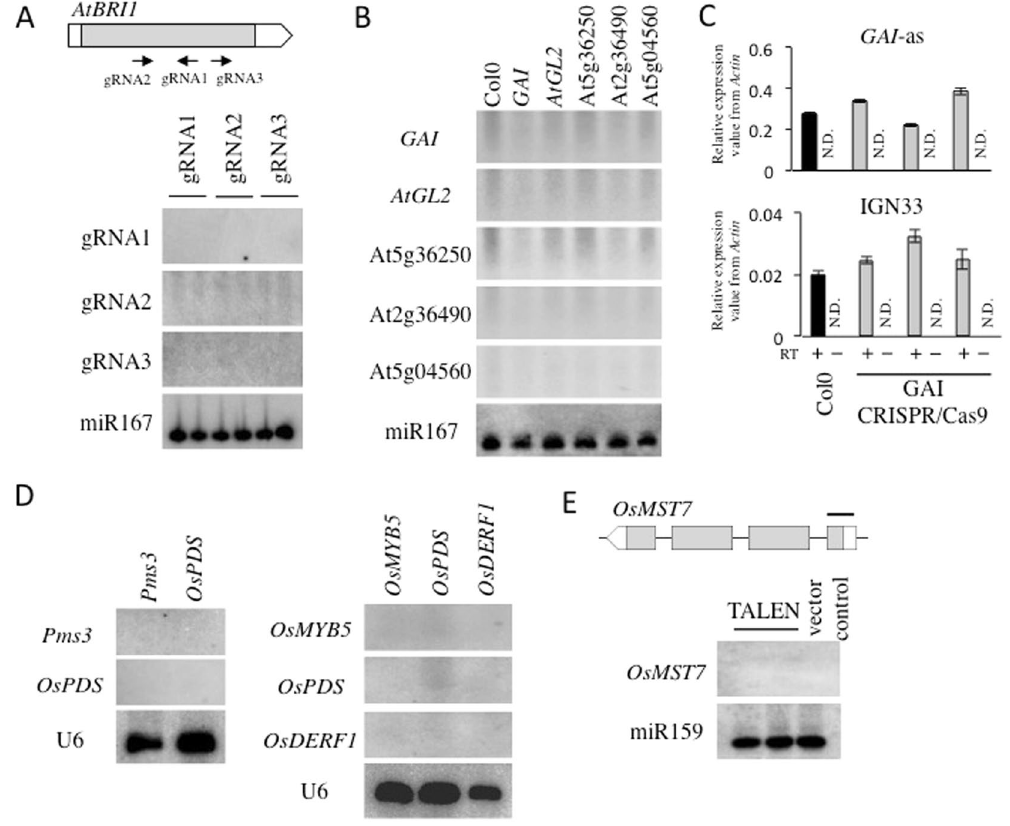
Figure 2. diRNAs are not detected at endogenous genes in Arabidopsis and rice. ( A ) Three independent CRISPR/Cas9 constructs target to AtBRI1 . The top panel is a schematic representation of AtBRI1 gene and three CRISPR/Cas9 gRNA target sites. Northern blot analysis was performed with LNA probes (see Supplemental Table 1) in AtBRI1 gene targeted CRISPR/Cas9 T1 transgenic lines. An miR167 probe was used as a control. ( B ) Northern blot analysis of small RNAs for additional endogenous genes ( GAI , AtGL2 , At5g36250, At2g36490 and At5g04560) targeted by CRISPR/Cas9. The Col0 accession and T1 transgenic plants were analyzed. ( C ) Detection of antisense transcripts at GAI by qRT-PCR, after targeting by CRIPR/Cas9. The same transgenic plants were used as in Fig. 2B. GAI -as indicates GAI antisense transcript. IGN33 was analyzed as a control. Black bar; Col0 with RT, gray bar; GAI targeting CRIPR/Cas9 with RT, white bar; without RT control. N = 3. N.D.; not detected. ( D , E ) Detection of small RNAs in endogenous genes targeted by CRISPR/Cas9 ( D ) and TALEN ( E ) in T0 transgenic rice. Horizontal line indicates TALEN target site and probe. U6 and miR159 were probed as controls. ( A , B , D , E ) Northern blotting image was cropped nearby